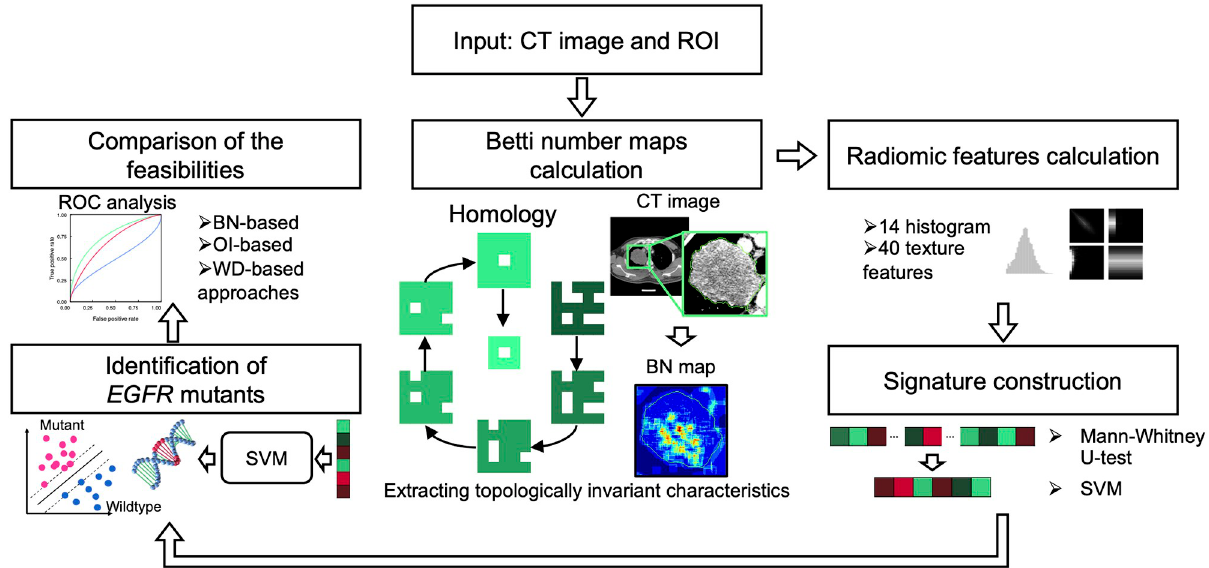
Fig 2. Overall workflow for the present study. CT: Computed tomography, ROI: Region of interest, BN: Betti number, SVM: Support vector machine, EGFR : Epidermal growth factor receptor, OI: Original image, WD: Wavelet-decomposition.